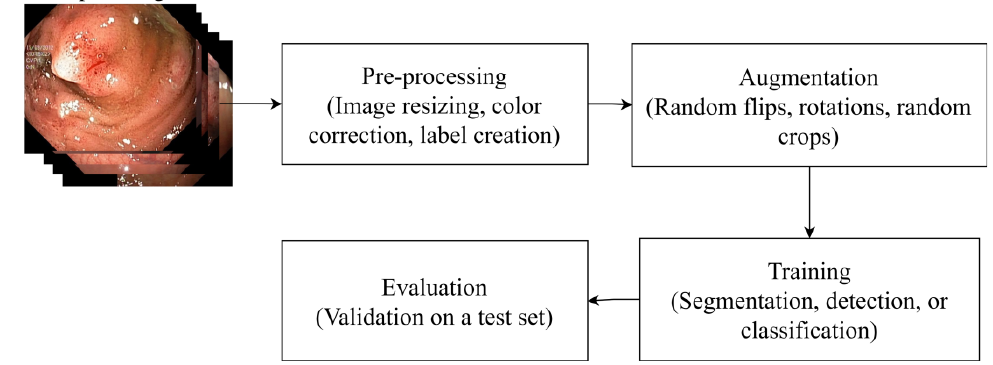
Figure 2. The standard steps required to build automatic polyp detection models. Samples in this illustration are taken from